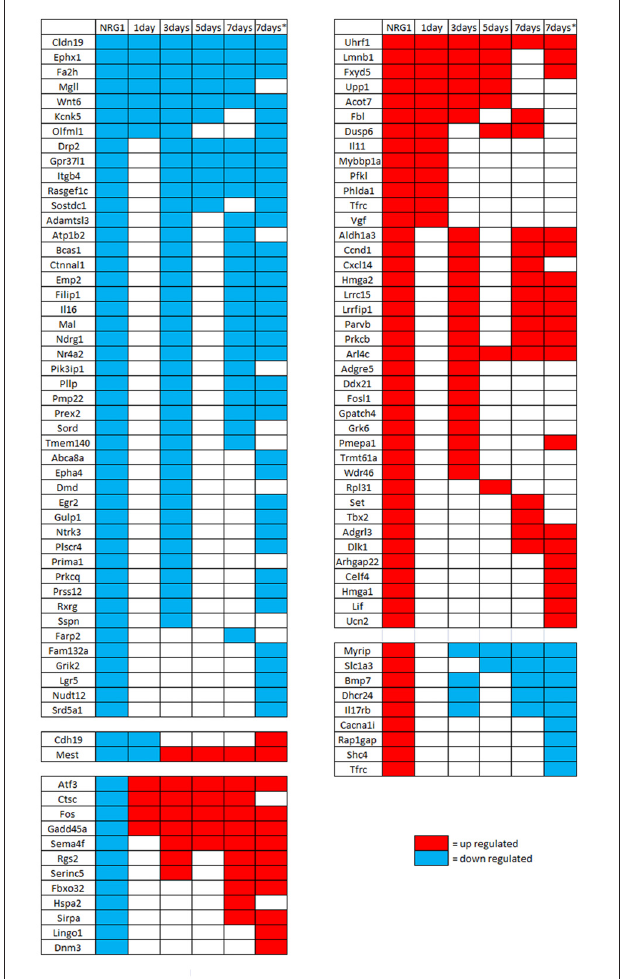
FIGURE 4 | Genes differentially regulated in vitro by NRG1 compared with 1–7 days injured nerves. Genes significantly regulated following NRG1 stimulation (101 up- and 89 down-) were compared with genes regulated 1 and 5 days after sciatic nerve cut (Kim et al., 2012), 3 and 7 days after sciatic nerve microcrush (Barrette et al., 2010), and 7 days ( ∗ ) after sciatic nerve cut (Arthur-Farraj et al., 2017). Among them, 40 up-regulated and 46 down-regulated show the same regulation behaviour at different time points after injury, 9 up-regulated and 12 down-regulated show an opposite behaviour, two down-regulated genes show a mixed